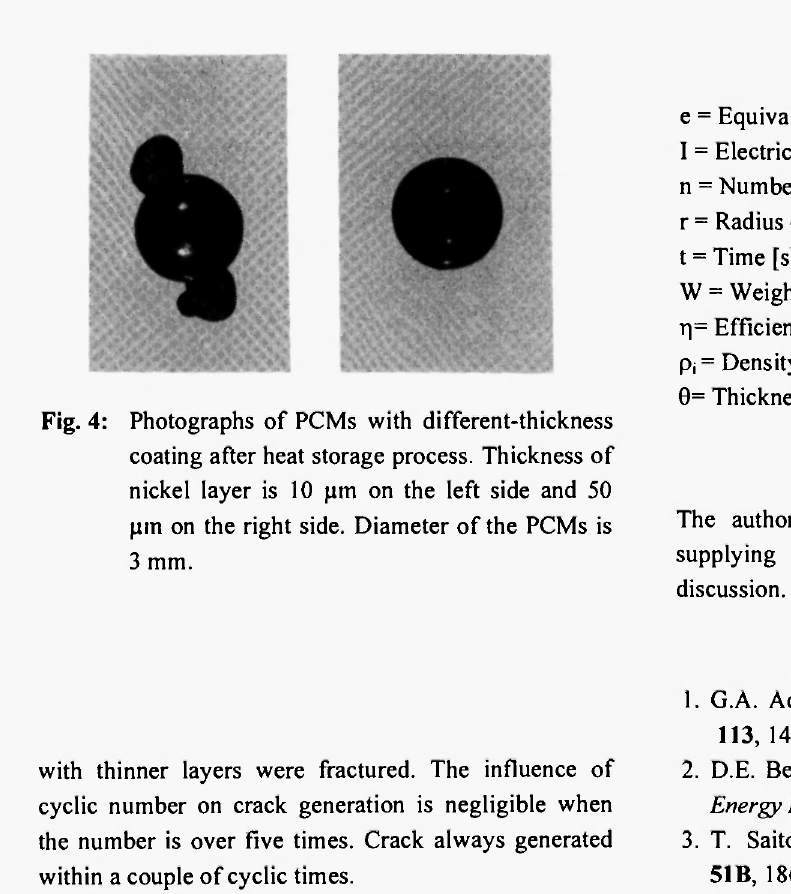
with thinner layers were fractured. The influence of cyclic number on crack generation is negligible when the number is over five times. Crack always generated within a couple of cyclic